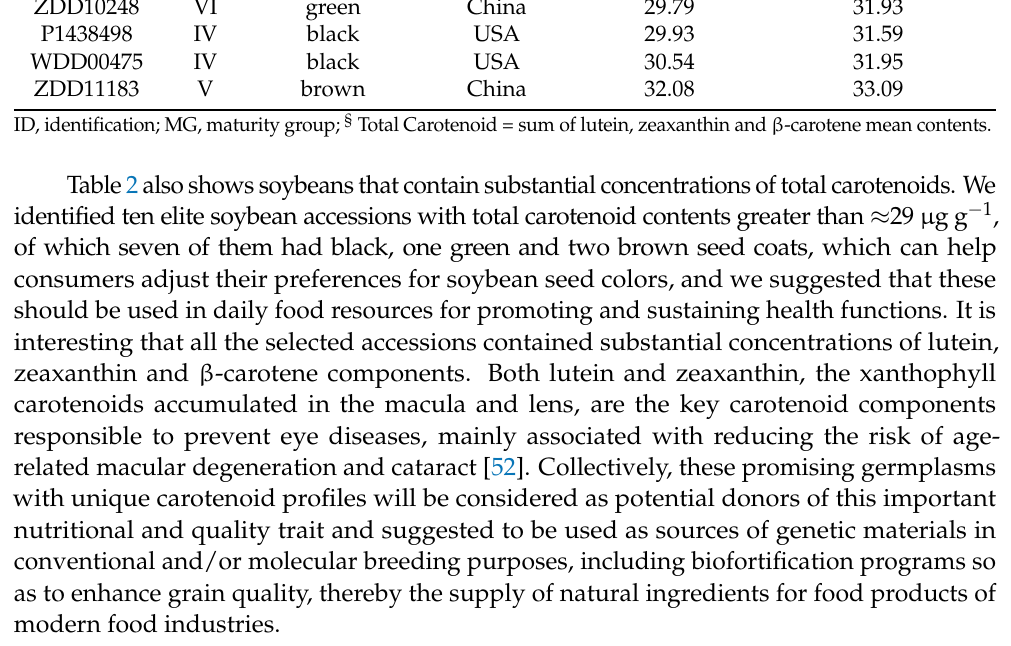
Seed Coat Color